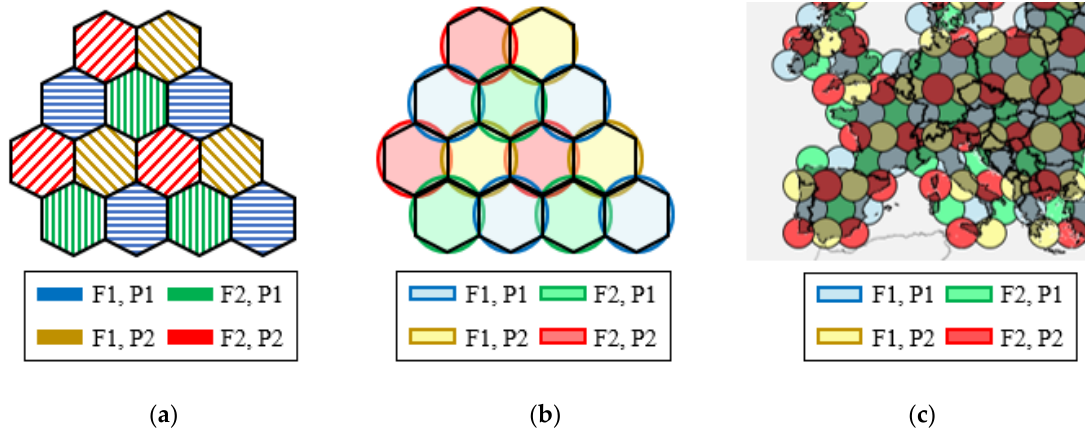
Figure 1. Example of a four-color multispot coverage. ( a ) Hexagonal service cells working in four different colors. ( b ) Hexagonal cells covered by circular beams generated in two orthogonal polarizations (P1, P2) and two frequencies (F1, F2). ( c ) Example of a European four-color coverage that would be generated by a geostationary satellite.